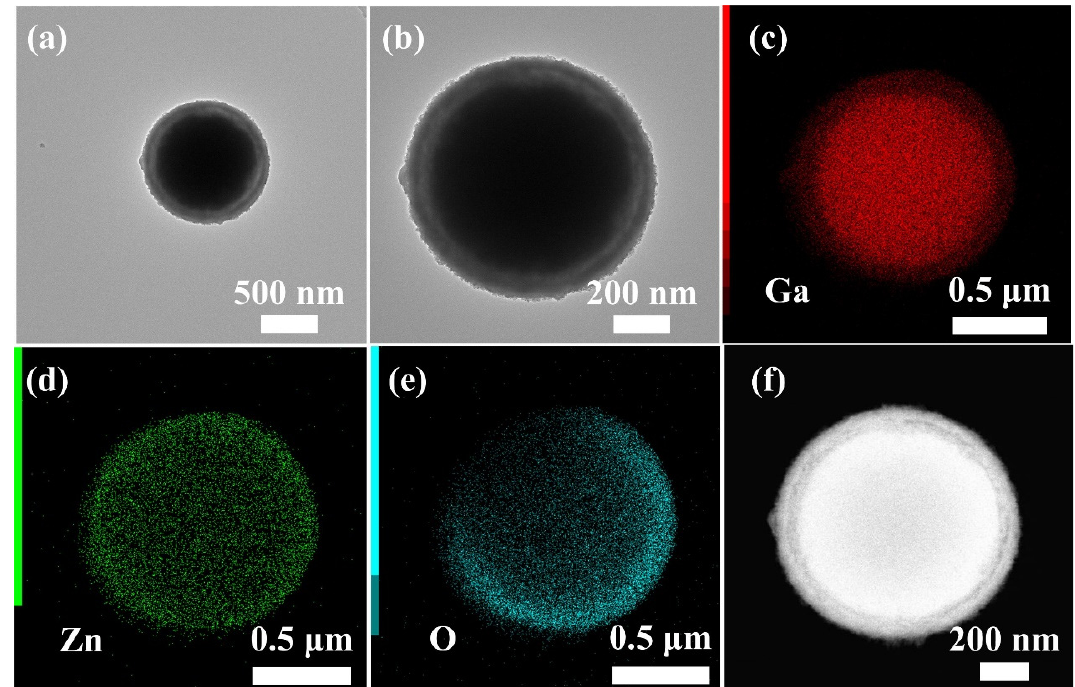
Figure 4. ( a , b ) TEM morphology of the Ga 2 O 3 /ZnO at different magnifications, and the elemental mapping of ( c ) Ga, ( d ) Zn, ( e) O, and ( f ) the stem microstructure of Ga 2 O 3 /ZnO.